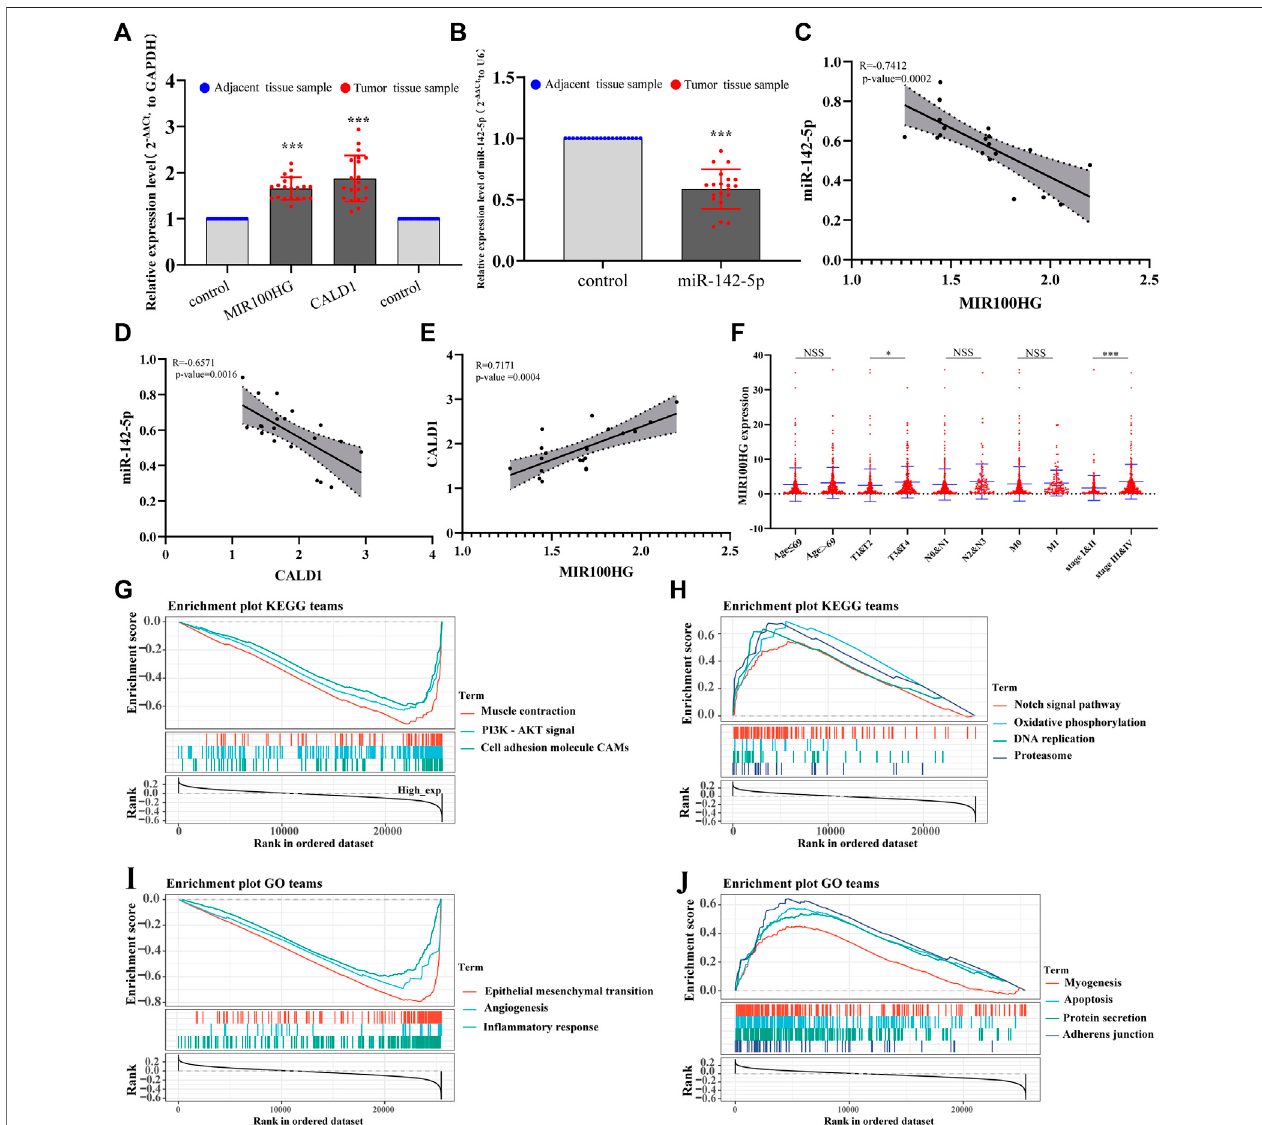
FIGURE 7 | (A) The relative expression levels of MIR100HG and CALD1 in bladder cancer tissues and adjacent tissues using qPCR. The blue dots represent adjacenttissuesamplesofbladdercancer.Thereddotsrepresentbladdercancertissuesamples.TheexpressionlevelofGAPDHwasusedasaninternalreference.The data are shown as the mean ± standard deviation. The left “ control ” on the X axis represents the relative expression of MIR100HG in the adjacent tissue samples (as a reference, the expression value was 1). The right “ control ” represents CALD1 relative expression in the adjacent tissue samples (as a reference, the relative expression value was 1). (B) The expression levels of miR-142-5p in bladder cancer tissues and adjacent tissues using qPCR. The blue dots represent adjacent tissue samplesof bladder cancer. The red dots representbladder cancer tissue samples.The expression level ofU6 was used asan internal reference. Thedata are shown as the mean ± standard deviation. The “ control ” on the X axis represents the relative expression of miR-142-5p in the adjacent tissue samples (as a reference, the relative expression value was 1). (C,D,E) Correlation analysis of MIR100HG, miR-142-5p and CALD1 relative expression levels in 20 pair bladder cancer tissue samples and adjacenttissuessamples. (F) CorrelationsbetweenMIR100HGexpressionandclinicopathologicalcharacteristicsofbladdercancer.ThereddotsrepresentMIR100HG expression in TCGA- BLCA samples. “ Age ≤ 69 and age > 69 ” represents the age group of TCGA-BLCA, and 69 is the median age value of patients. “ T, N and M ” representsthetumorpathologicalstageofpatientsinTCGA-BLCA, “ & ” representstheintegrationoftwodataintoonedata. “ Stage ” representsthetumortissuestageof patients in TCGA-BLCA. (G,H,I,J) Gene set enrichment analysis (GSEA) of MIR100HG in TCGA-BLCA patients. (G) : KEGG terms with negative correlation with MIR100HG expression. (H) : KEGG terms with positive correlation with MIR100HG expression. (I) : GO terms with negative correlation with MIR100HG expression. (J) : GO terms with positive correlation with MIR100HG expression. *** p -value < 0.001. * p -value < 0.05.NSS: no statistical signi fi